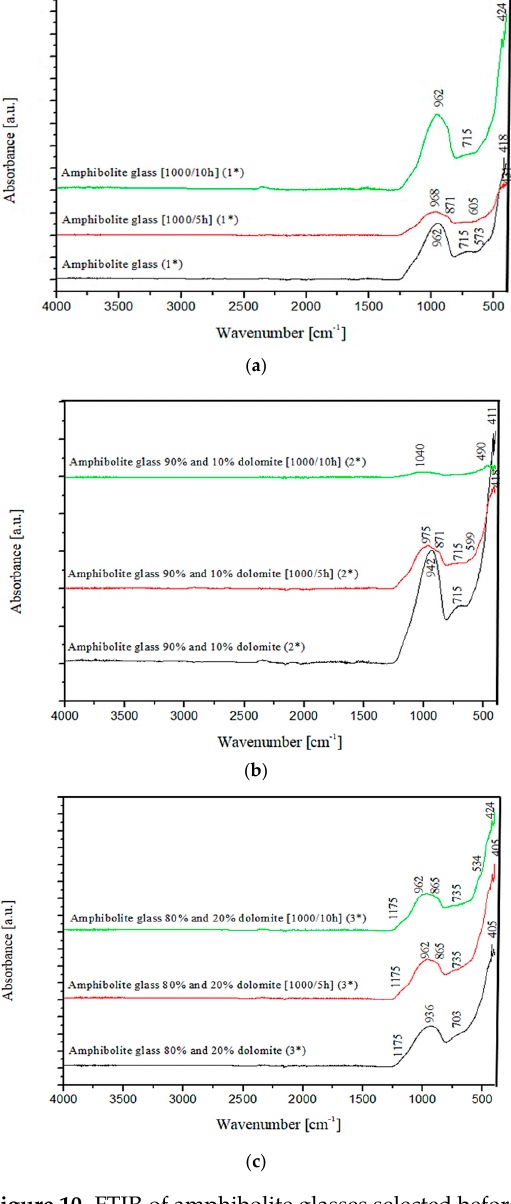
Figure 10. FTIR of amphibolite glasses selected before and after crystallization process: ( a ) 100 wt.% amphibolite (1*), ( b ) 90 wt.% amphibolite + 10 wt.% dolomite (2*), ( c ) 80 wt.% amphibolite + 20 wt.% dolomite (3*).